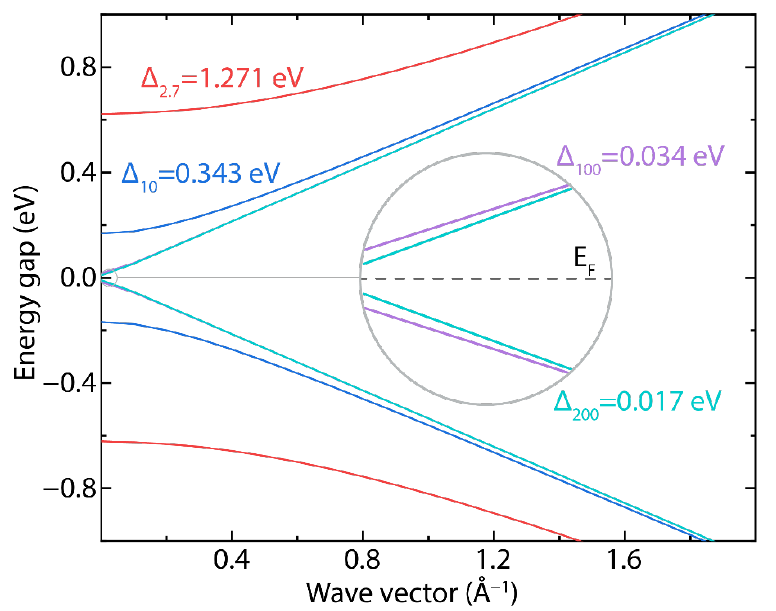
Figure 6. Band structure of GNRs (cfr. Equation (2), n = 1) as a function of parallel component k (cm − 1 ), considering different widths: w = 2.7, 10, 100, and 200 nm. The inset shows a magnification to resolve the small bandgap of the wider ribbons.